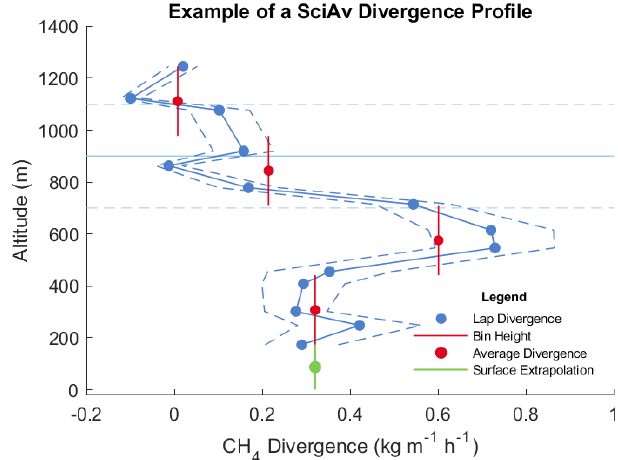
Figure 3. An example of a SciAv profile used in the second step of the method. The blue points are the estimated flux divergence for each lap, which are connected to show profile shape with the asso- ciated uncertainty (a dashed blue line). Red points are bin averages, and the vertical red bar is the bin height range. The boundary layer height is drawn in light blue with error bars (light blue dashed lines). The standard SciAv surface extrapolation method of extending the lowest red bin to the surface is shown in